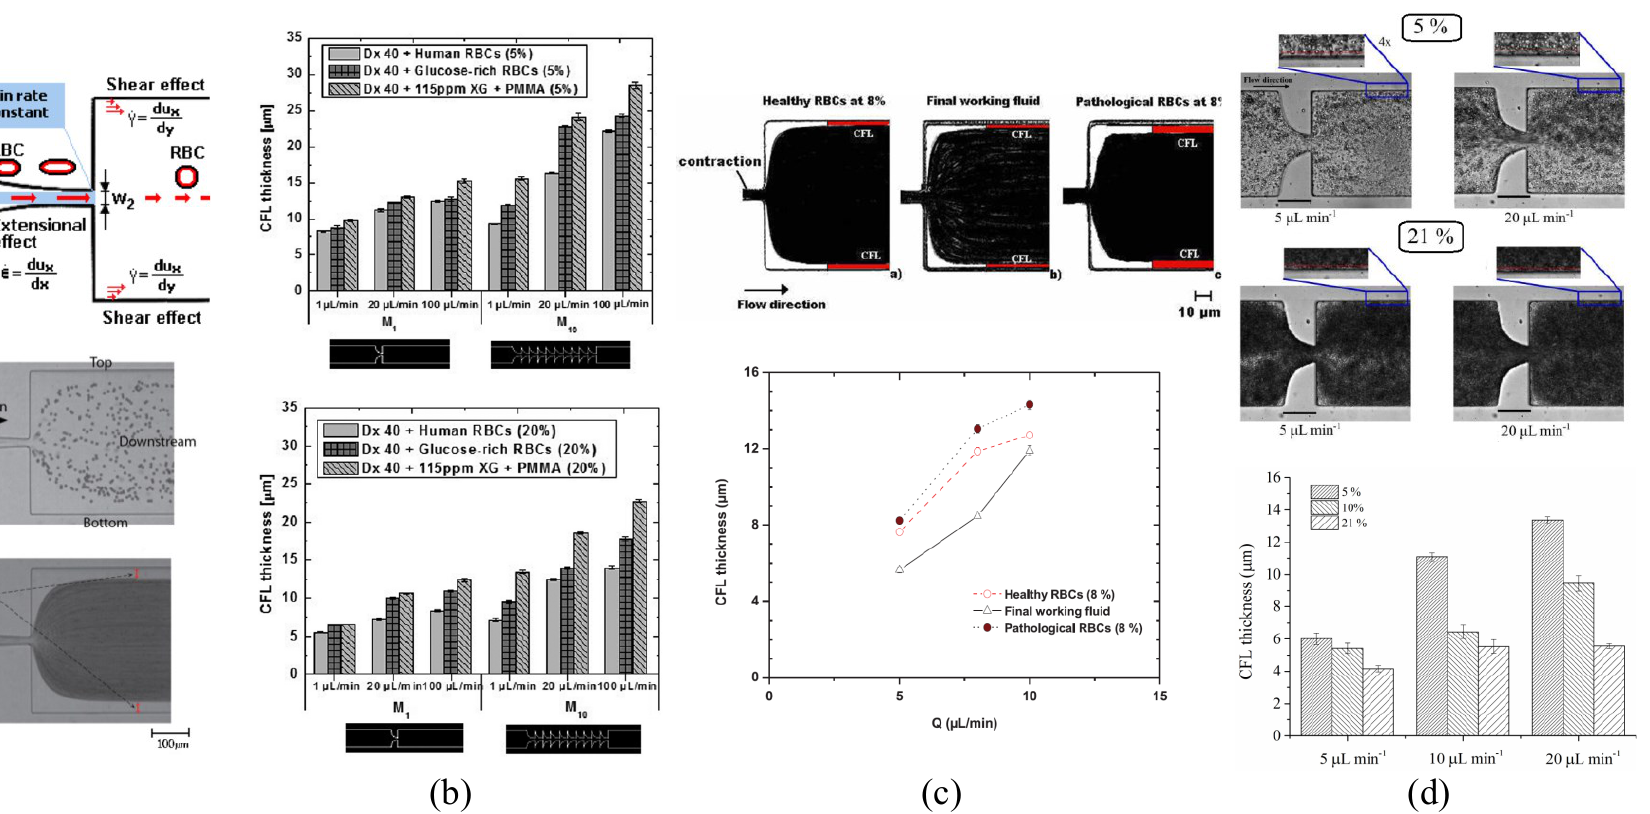
Figure 11. ( a ) Sketch of the flow behaviour in a microchannel with hyperbolic contraction (upper-part), with a particulate fluid of RBCs undergoing a constant strain-rate only along the contraction center-line, with a shear effect only at the microchannel walls [46]. Flow visualization (lower-part) for the CFL thickness analysis using ImageJ software for post-processing with the small vertical red line representing the CFL [54]. CFL thickness analysis downstream of a contraction microchannel for ( b ) three types of particles (PMMA, healthy RBCs, and glucose-rich RBCs) at concentration of 5 wt% and 20 wt%, and with flow rates of 1, 20, and 100 µ L/min in two different microchannels [55]; ( c ) three types of particles (PDMS, healthy RBCs, and pathological RBCs) with flow rates of 5, 8, and 10 µ L/min [46], ( d ) three types of particles (PDMS of 5, 10, and 21 wt% concentrations) at the flow rate of 5, 10, and 20 µ L/min [52]. Reproduced from Refs. [46,52,54,55] with permission from MDPI, AIP Publishing, Elsevier Science INC, and The Royal Society of